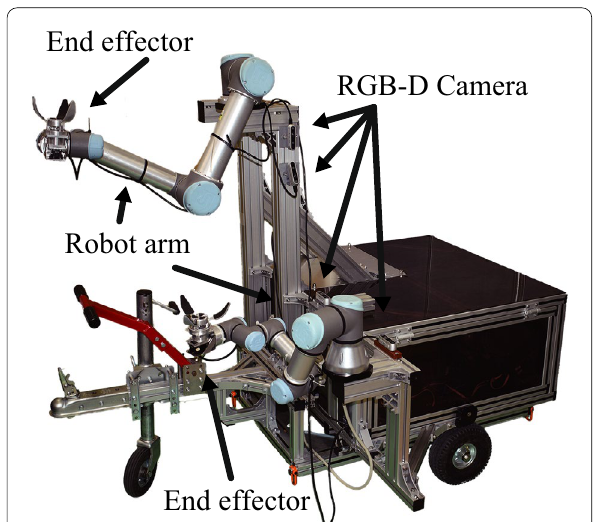
Fig. 1 Components of harvesting robot